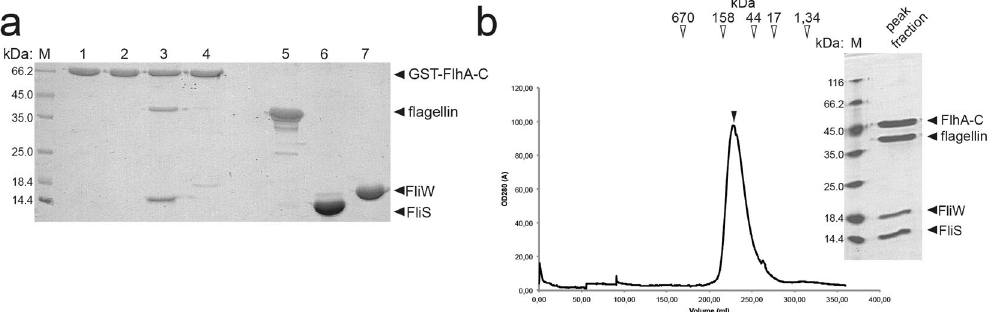
Figure 5. FliW is not a prerequisite for flagellin recognition by FlhA-C. ( a ) Coomassie-stained SDS-PAGE of a pulldown assay employing GST-tagged FlhA-C. Flagellin alone does not interacts with FlhA-C (lane 2). FliS alone is able to recruit flagellin to FlhA-C (lane 3), while FliW alone is not (lane 4). Lanes 1, 5, 6 and 7 represent the input of purified GST-FlhA-C, Flagellin, FliS and FliW, respectively. ( b ) Reconstitution of the FliS/flagellin/ FliW/FlhA-C complex on size exclusion chromatography shows an apparent heterotetramer. Arrows indicate the protein size standard in kDa. The inset shows a Coomassie-stained SDS-PAGE of the peak